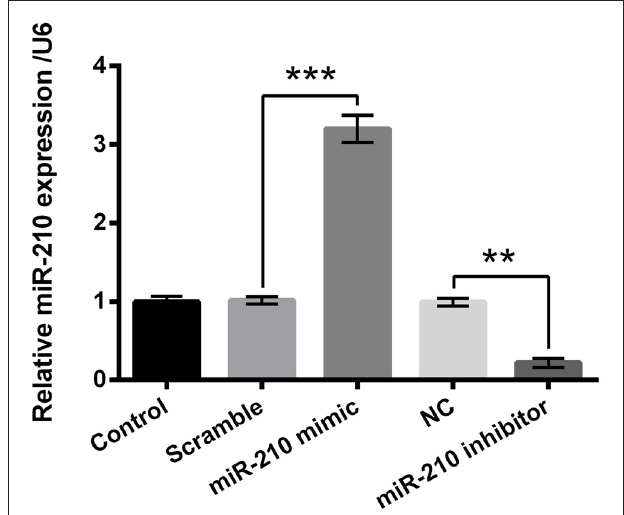
FIGURE 3 | Overexpression or suppression of microRNA (miR)-210 by mimic or inhibitor transfection. Data presented are the mean ± SEM of at least three independent experiments. ∗∗ P < 0.01; ∗∗∗ P < 0.001. NC, negative control of miR-210